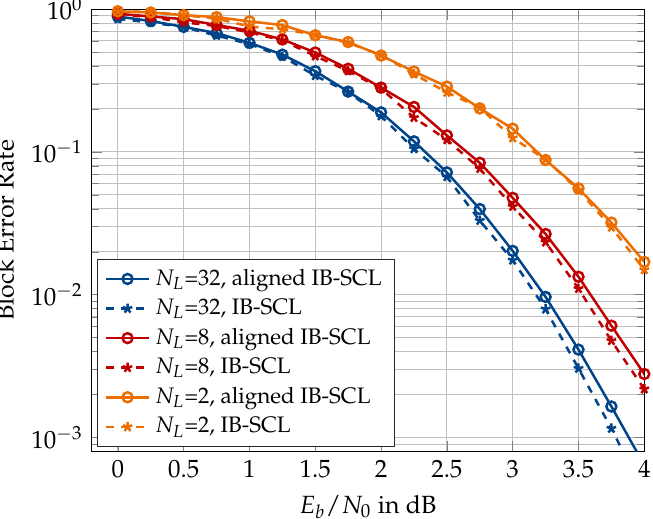
Figure 23. Block error rate of a 4-bit aligned information bottleneck SCL decoder with alignment cardinality |T ∗ | = 16, 16-bit CRC, N = 128, N L = 2,8 or